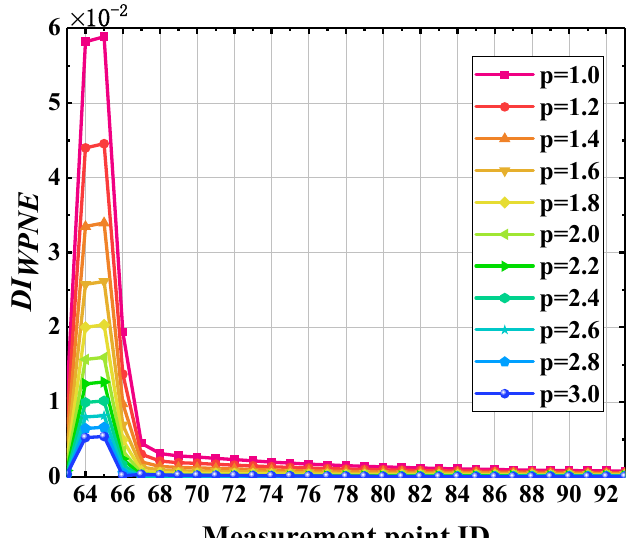
Figure 10. Identification results of different p values.